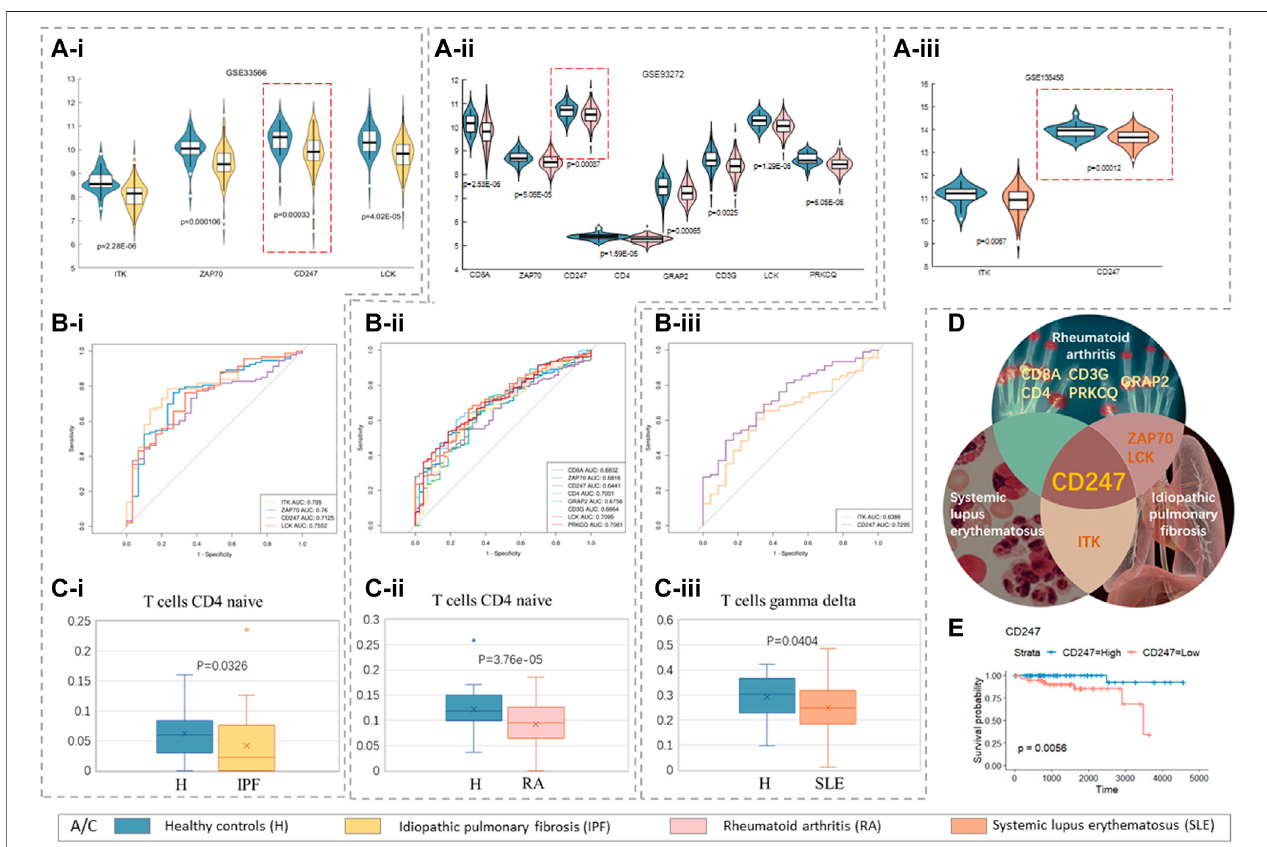
FIGURE7| Paraneoplasticsyndrome. (A – i) Idiopathicpulmonary fi brosis,GSE33566; (A – ii) rheumatoidarthritis,GSE93272; (Aiii) systemiclupuserythematosus, GSE138458; (A – i,ii,iii) violin maps of hub genes with signi fi cant differences in expression in three PNS. (B – i,ii,iii) The area under the curve of these signi fi cant genes (AUC) by receiver operating characteristics (ROC) analysis. (C – i,ii,iii) The box patterns of T-cells with signi fi cant differences in the proportions of three PNS. (D) Outline map of intersection genes of three PNS (cf. Table 2.XLSX of the Supplementary Materials ). (E) The Kaplan – Meier survival curves of CD247.